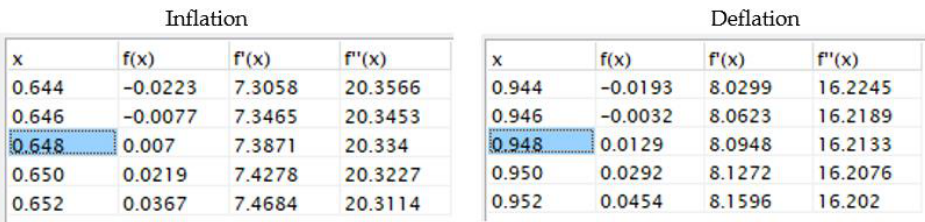
Figure 12. Evaluation of the slopes of the tangents to the curves defined by Equations (7) and (8).